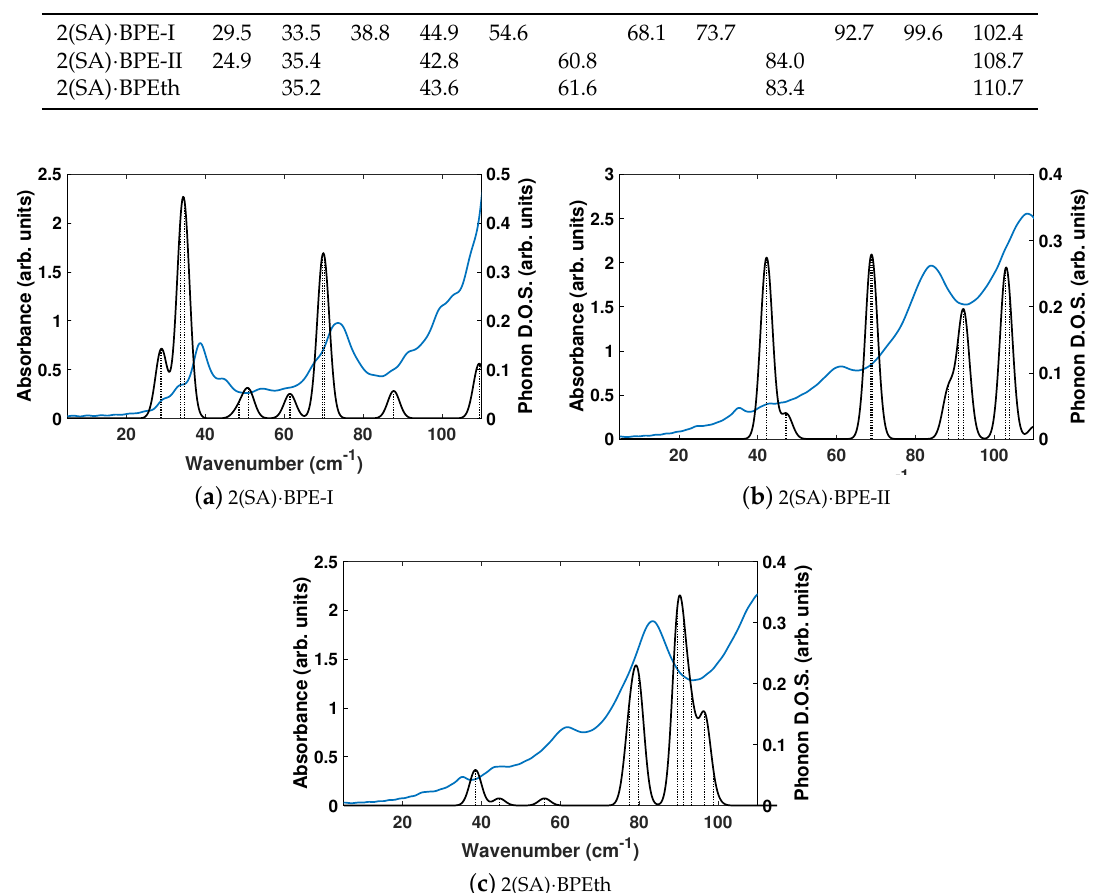
Table 7. Experimentally determined THz frequencies for the co-crystals 2(SA) · BPE form I and II, and 2(SA) · BPEth, given in units of cm − 1 . Values are partitioned to highlight similarities and differences.